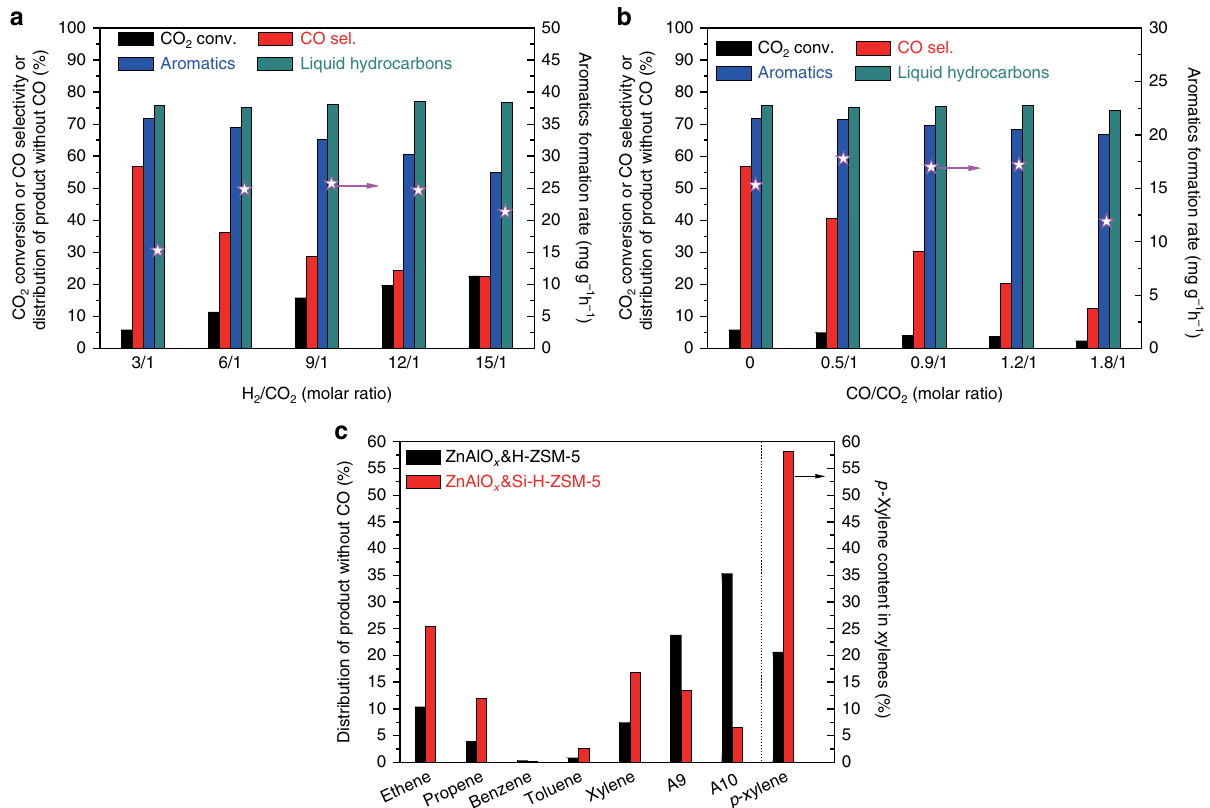
Fig. 3 The results of selectivity optimization for CO 2 hydrogenation. a The effect of H 2 /CO 2 ratio over ZnAlO x &H-ZSM-5. Reaction conditions: Space velocity = 6000 ml g − 1 h − 1 , 3.0 MPa, 593 K. b The effect of CO introduction over ZnAlO x &H-ZSM-5. Reaction conditions: catalyst weight = 667mg, 3.0 MPa, 593 K, inlet gas containing 66.7 ml min − 1 mixed gas (H 2 /CO 2 /Ar = 3/1/0.2) and 0 – 26.6 ml min − 1 CO. c Comparisons of catalytic behaviors over ZnAlO x &H-ZSM-5 and ZnAlO x &Si-H-ZSM-5. Reaction conditions: Space velocity = 6000 ml g − 1 h − 1 , 3.0 MPa, 593 K, H 2 /CO 2 /Ar = 3/1/0.2. A9 and A10 are representative of aromatics containing 9 and 10 carbon atoms,